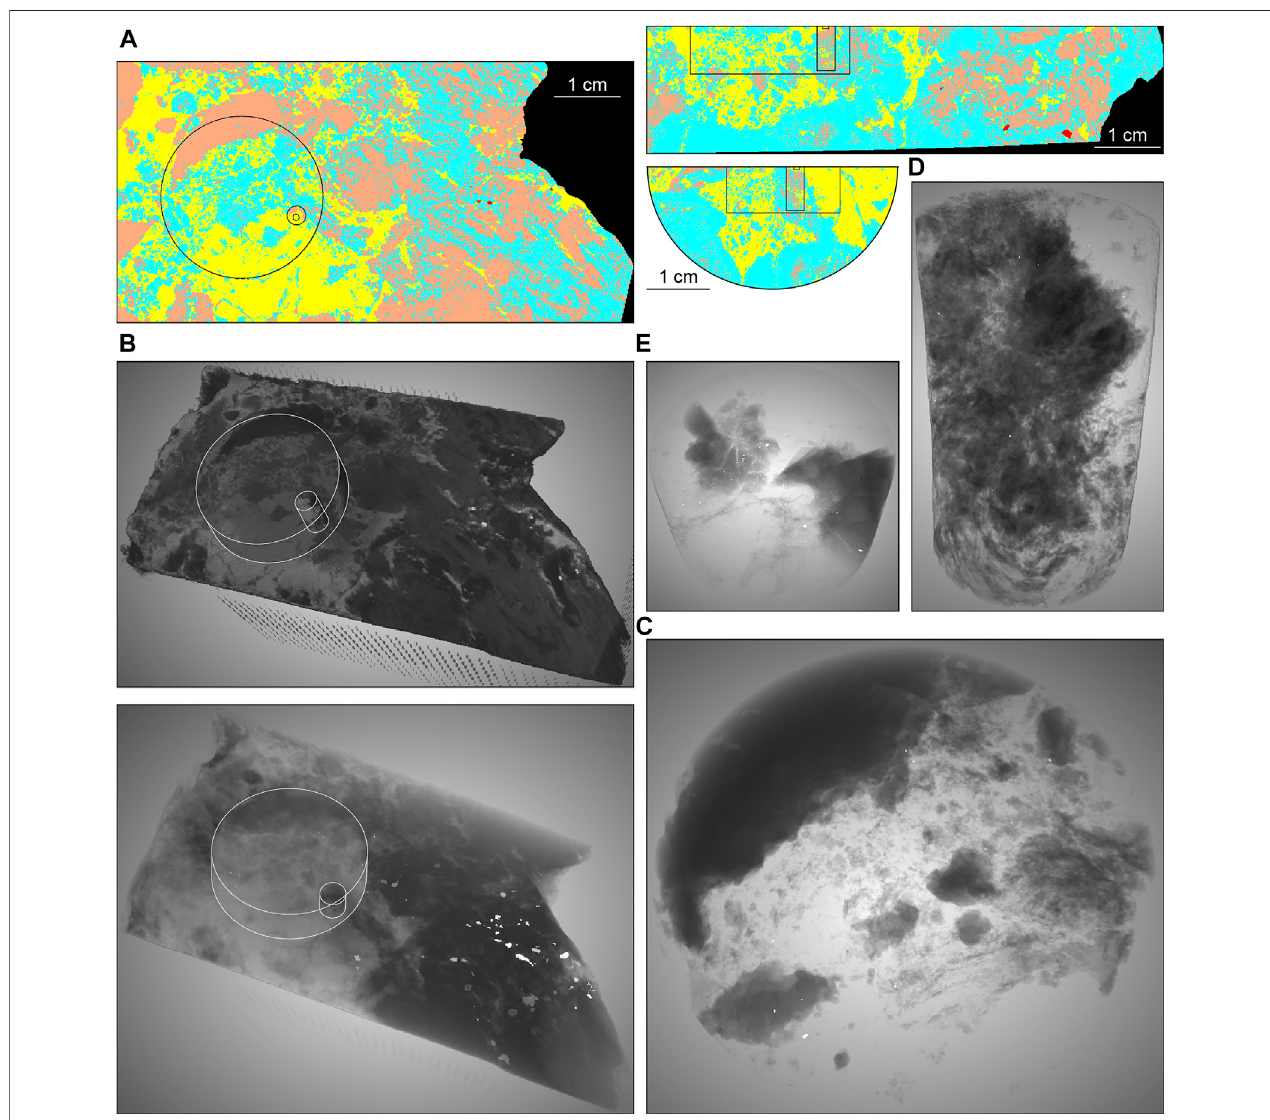
FIGURE 4 | XCT images of the drill core piece, rock chip, and mini core of sample 2. For color coding of the minerals, see Table 2 . (A) Segmented XCT images of the various scans (45, 30, 4, and 1 μ m voxel size) along the three spatial axes. (B) Opaque (top) and transparent (bottom) 3D-rendered XCT images of the drill core piece, rock chip, and mini core. The black and dark grey phases correspond mainly to silicates and carbonates, the medium grey phases to sul fi des, and the bright phases to heavy minerals (e.g., scheelite, galena, Au- and Bi-minerals). (C) 3D-rendered XCT image of the rock chip (30 μ m voxel size). The sul fi des are rendered transparent to better reveal the heavy mineral inclusions (bright grains). (D) 3D-rendered XCT image of the mini core (4 μ m voxel size). The sul fi des are rendered transparent to better reveal the heavy mineral inclusions (bright grains). (E) 3D-rendered XCT image of the volume of interest within the mini core (1 μ m voxel size). The sul fi des are rendered transparent to better reveal the heavy mineral inclusions (bright